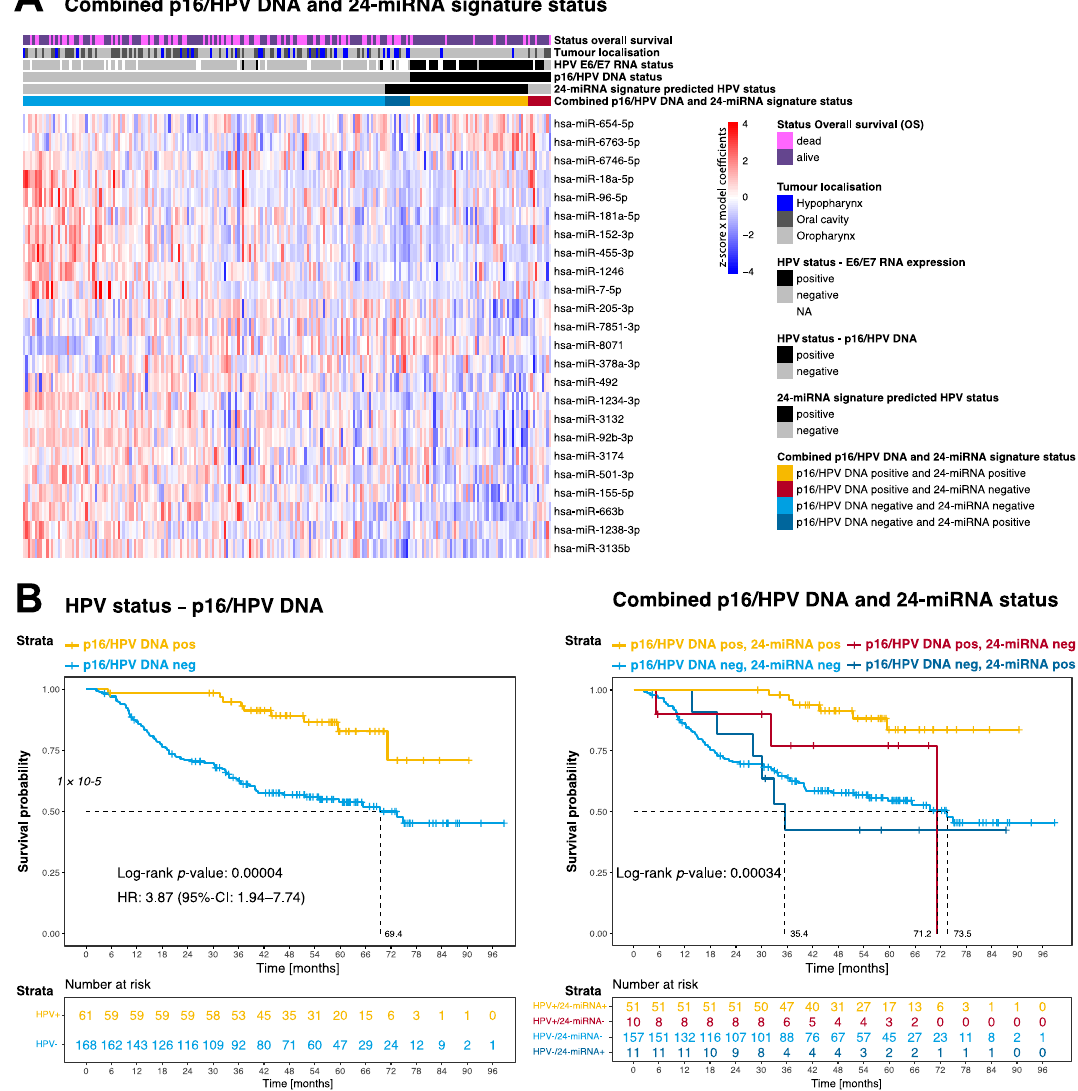
Figure 3. Combined p16/HPV DNA and 24-miRNA signature status. ( A ) Heat map colours indicate scaled miRNA log2 expression values multiplied by the model coefficients from low (blue) to high (red) on a scale of − 4 to 4 for each of the 24 signature miRNAs. Information on overall survival status, tumour localisation, E6/E7 RNA expression HPV status, p16/HPV DNA status (ground truth), 24-miRNA signature predicted HPV status and combined p16/ HPV DNA and 24-miRNA signature status are indicated on a case-by-case basis. ( B ) Kaplan–Meier curves for the endpoint overall survival according to p16/HPV DNA status (left) and combined p16/HPV DNA and 24-miRNA signature status (right). p -values are derived by log-rank test. Hazard ratios (HR) with 95% confidence intervals (CI) and median overall survival times are given.